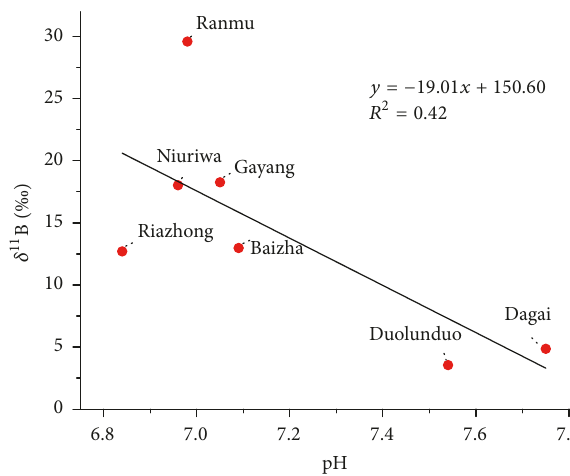
Figure 5: Relationship between 𝛿 11 B and